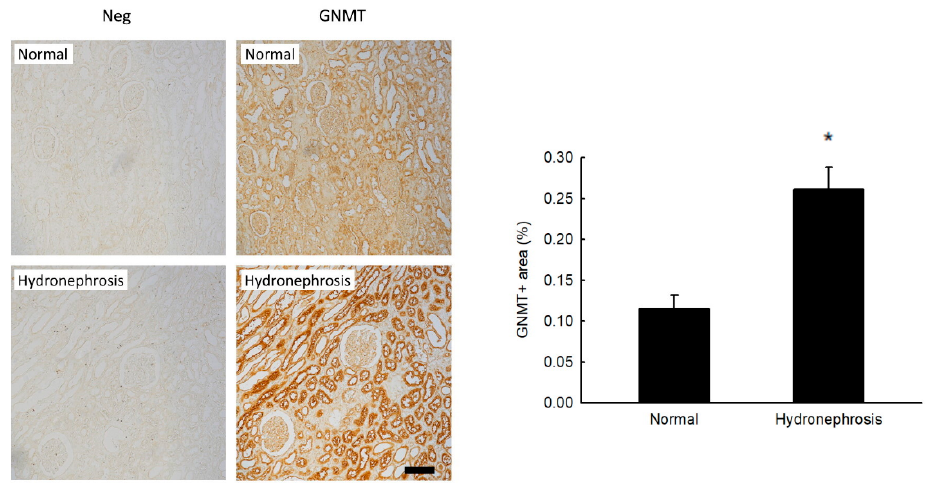
Figure 1. GNMT expression is upregulated in patients with obstructive nephropathy. The expres- sion of GNMT in the renal interstitium of kidney tissues was determined by immunohistochemistry. The data are presented as means ± standard errors. * p < 0.05 versus patients without obstructive nephropathy.